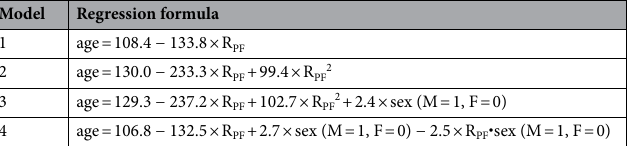
Table 2. The regression formulae used in this study. R PF : protein-folding intensity, R PF2 : the square of R PF .